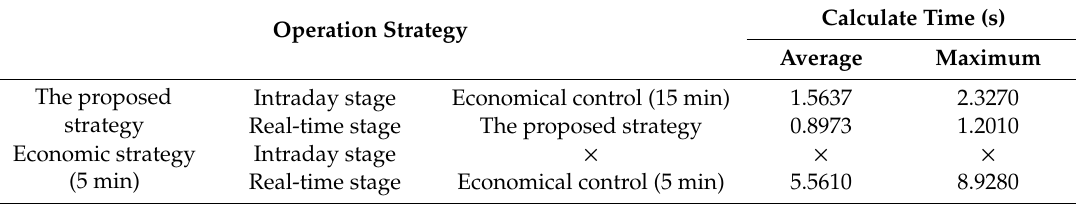
Table 4. Calculation time of the two intraday operating